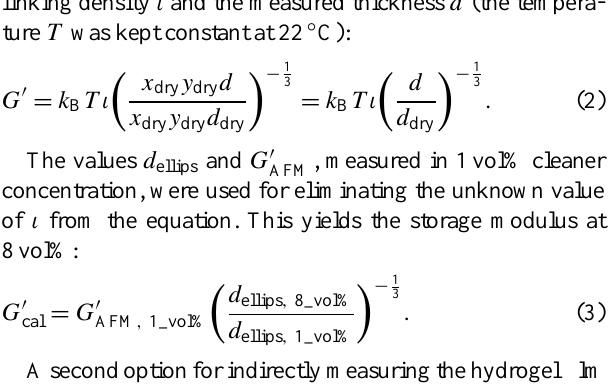
with G ∗ = G (cid:48) + iωη for the hydrogel and the index w